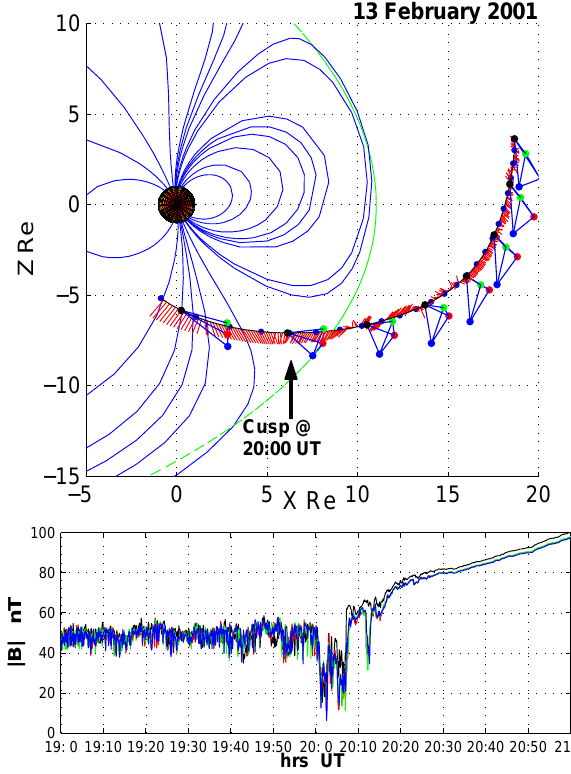
Fig. 8. The top panel shows the Cluster orbit on 13 February 2001 in the X − Z GSE plane. The lower panel shows the magnetic field magnitude measured by the four Cluster spacecraft between 19:00 and 21:00UT. The standard colour-coding is used. Note the field depression corresponding to the cusp between 20:00 and 20:10UT.